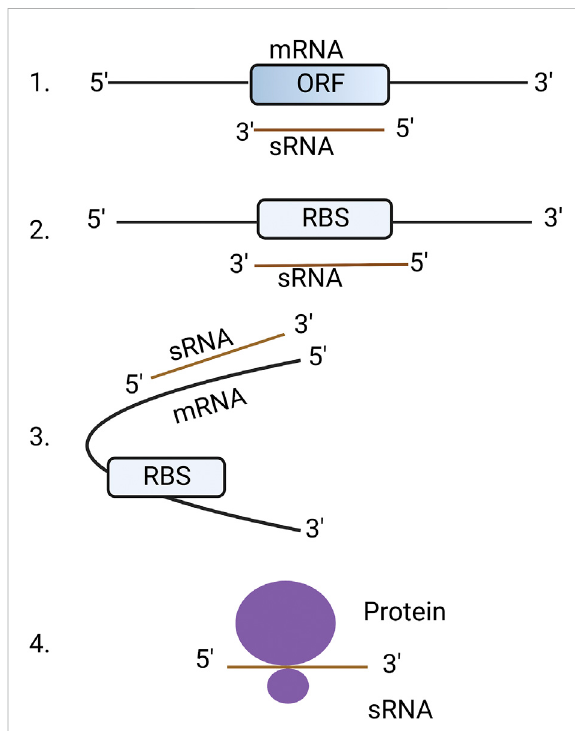
FIGURE 1 Mechanisms of bacterial sRNA regulation. 1. sRNA binds directly to open reading frame (ORF) of mRNA resulting in the degradation of RNA: RNA hybrid. 2. sRNA binds to ribosome bindingsite(RBS)resultinginblockingoftranslation.3.sRNAs bind to the outside of the RBS causing a conformational change that allows or blocks access to the RBS. 4. sRNA directly binds to proteins to change their structure and function. The fi gure was produced with biorender.com (adapted from https://www.